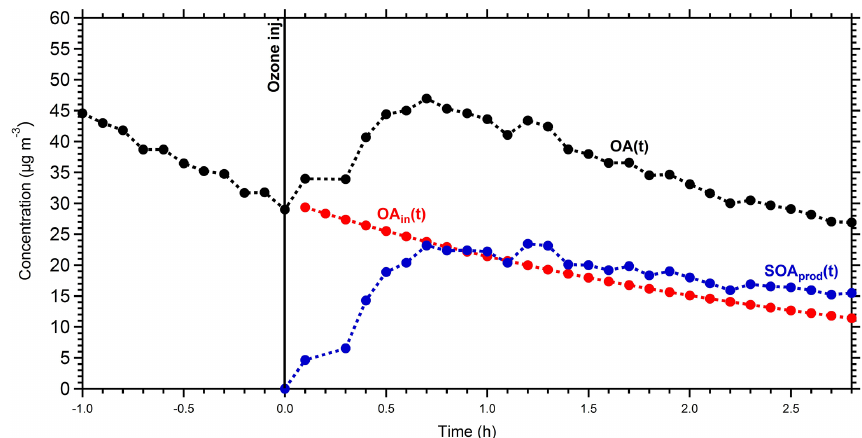
Figure 4. Mass concentration of the measured OA (black points), the initial OA (red points), and the produced SOA (blue points) in the perturbed chamber in Exp. 1. All concentrations refer to the suspended aerosol in the chamber and do not include the material deposited on the chamber walls.